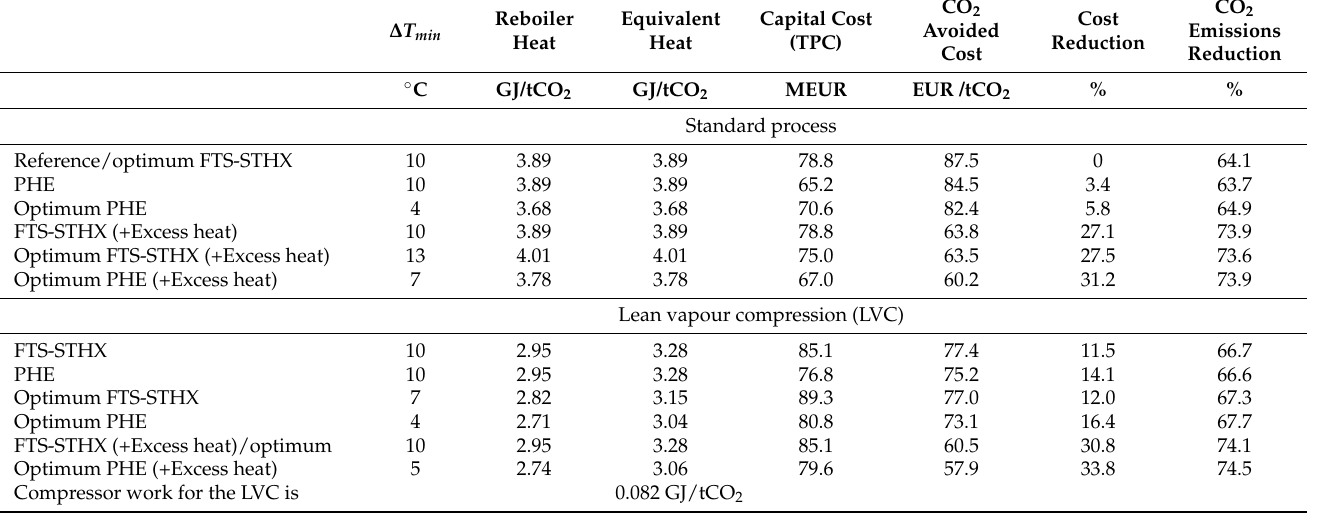
Table 16. CO 2 avoided cost and emissions reduction performances of FTS-STHX and PHE with and without available waste heat for 50% CO 2 capture from Brevik cement plant’s flue gas. Reboiler Equivalent ∆ T min Heat